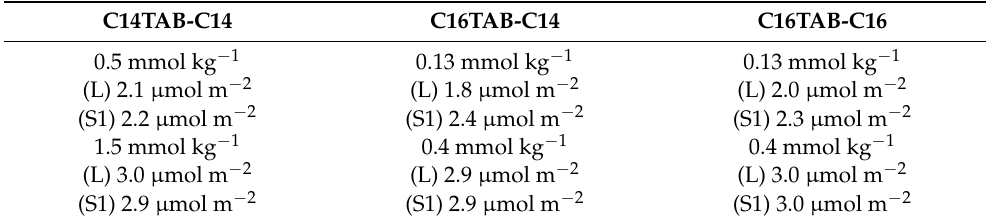
Table 1. Bulk concentration and surface density of surfactants at the experimental points applied to BAM experiments.